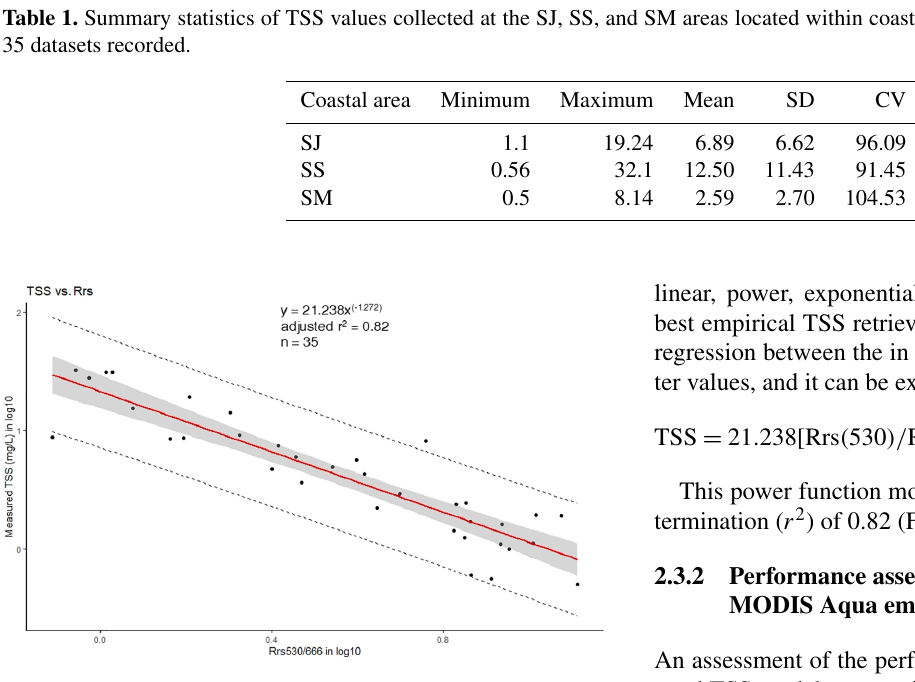
Figure 3. Empirical relationship of TSS retrieval between the in situ Rrs ( 530 )/ Rrs ( 666 ) band ratio and the measured TSS concen- tration (mgL − 1 ), as established via a power law function. The upper and lower dashed lines indicate the 95% prediction interval of the